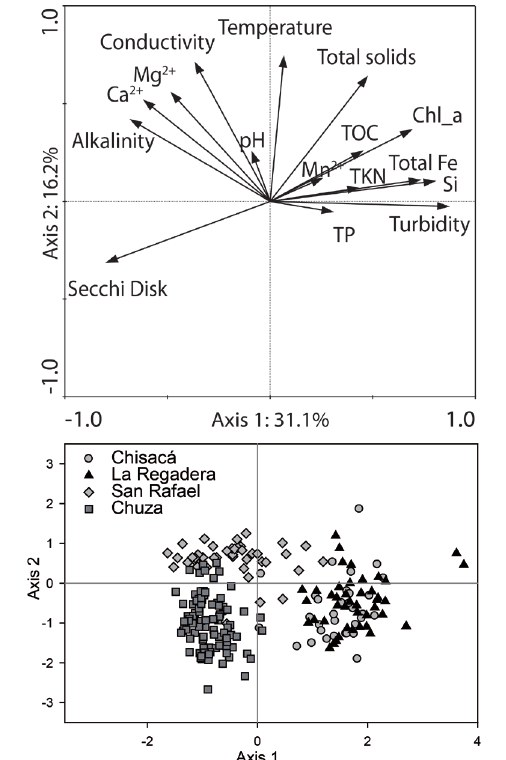
Figure 2. Biplot of the principal component analysis of physical and chemical variables of the studied